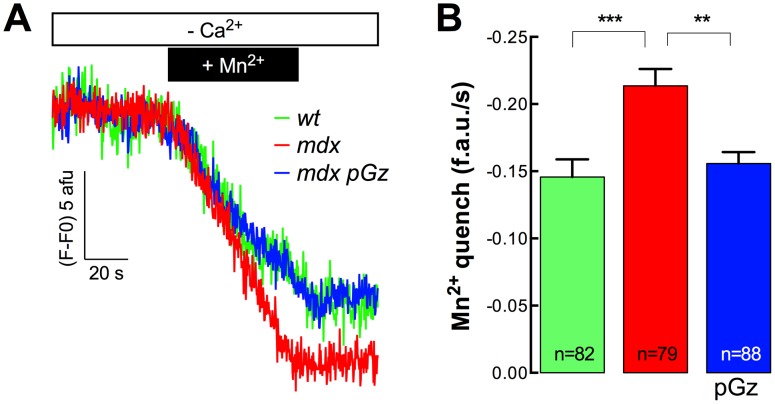
Resting rate of Mn2+ quench of Fura-2 fluorescence in pGz-treated mdx myotubes.A. Representative traces and B. average resting rates of Mn2+ quench. Data are expressed as mean ± S.E.M. **P<0.01, ***P<0.001, ANOVA-Tukey’s.